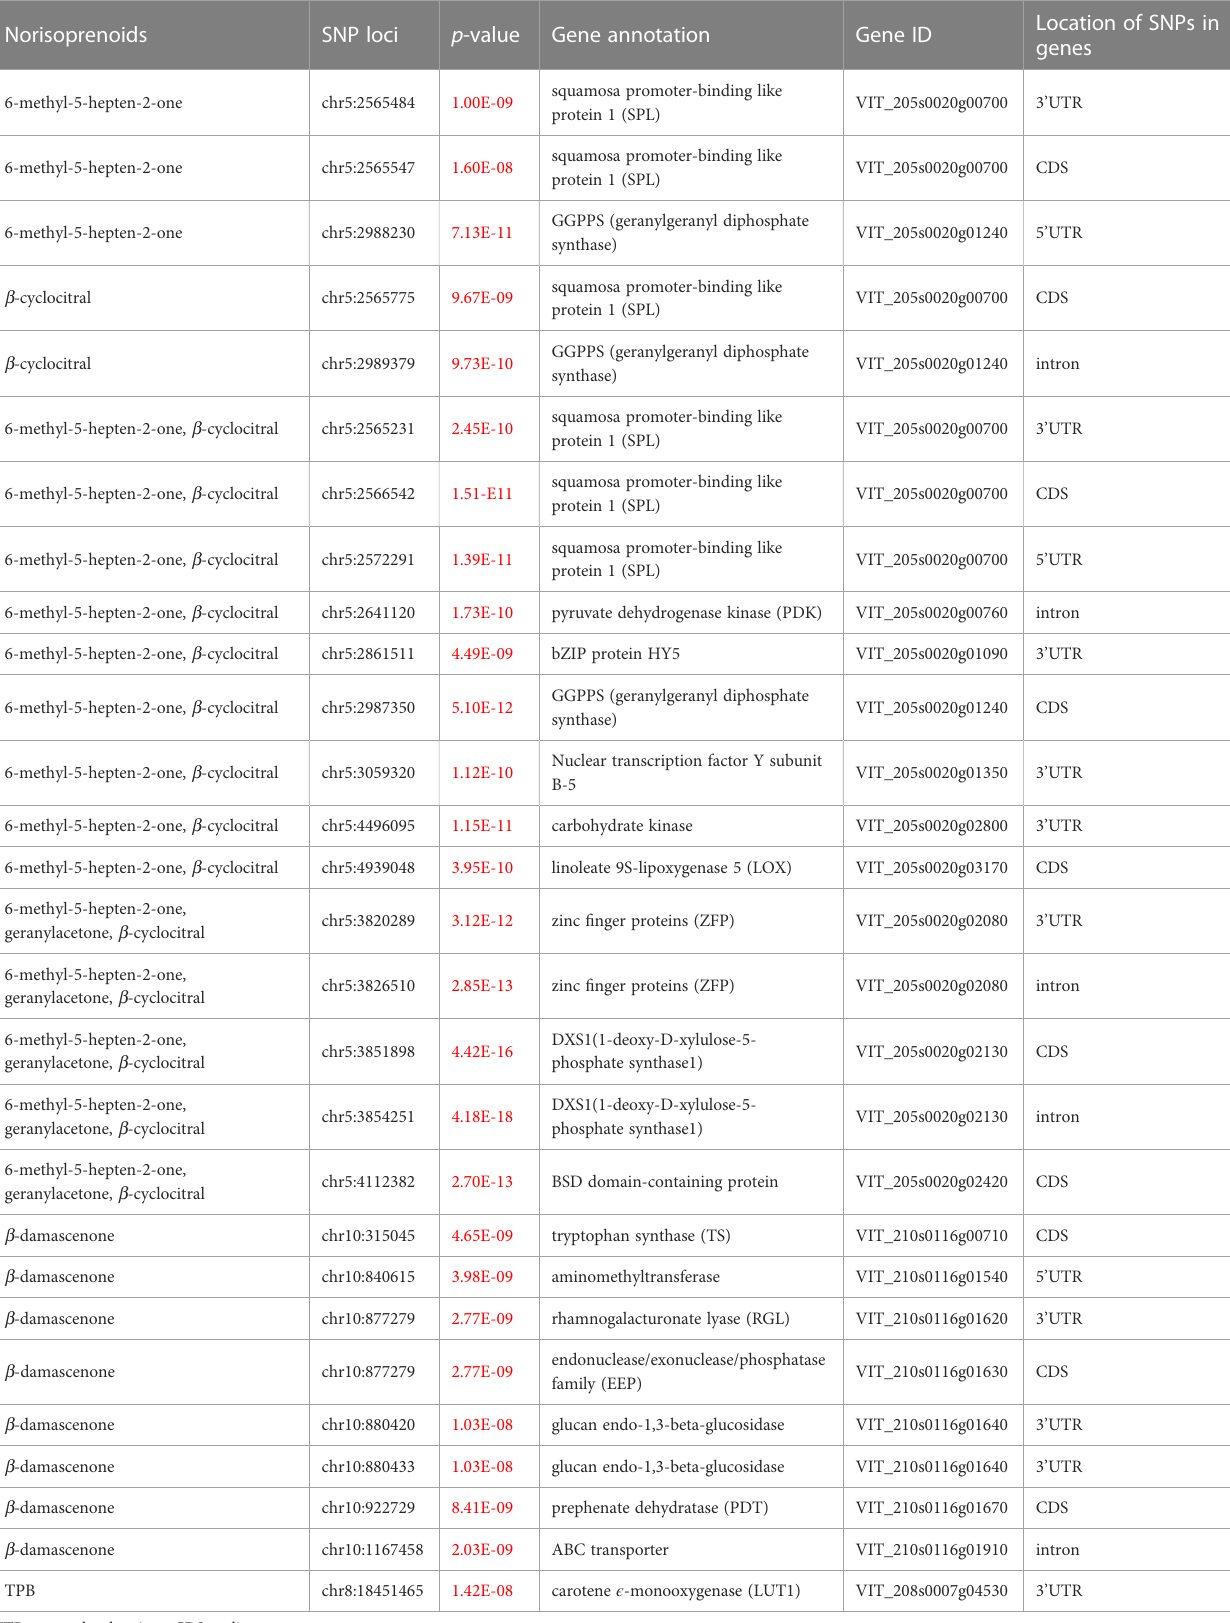
TABLE 3 Information of candidate signi fi cant SNP loci within genes and their gene